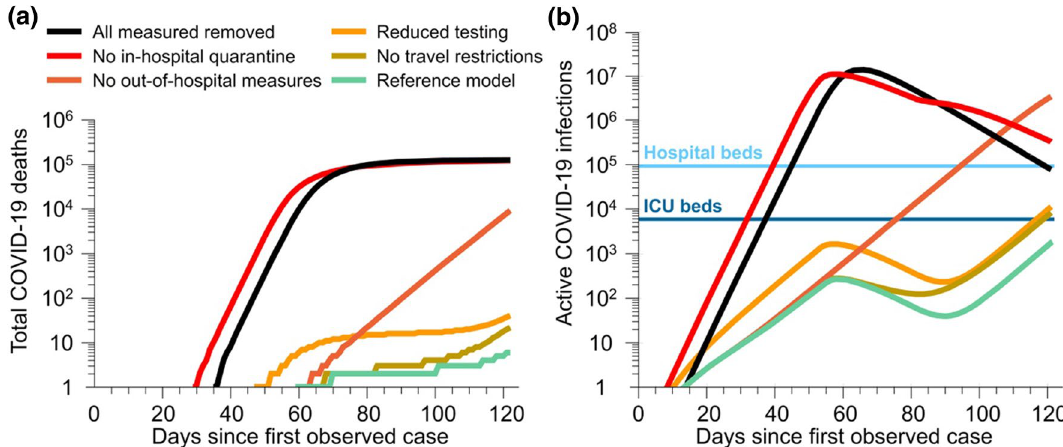
Figure 3. Results from the exploration of government measures. ( a ) Compares the deaths due to COVID-19 in the state, and ( b ) compares the active COVID- 19 cases in Kerala. The number of hospital beds and ICU beds available in Kerala are also